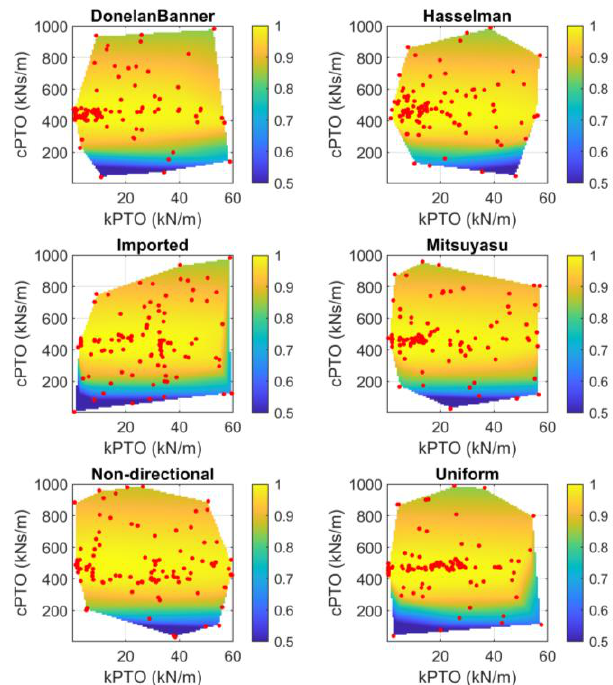
Fig. 6: Visualisation of the optimisation search space, with the colour bar showing the power produced, normalized to the maximum power produced in the non-directional case. Red dots represent the simulation results. Each panel shows a different distribution. Table 4: The first 2 columns show the optimal PTO stiffness and damping for the different optimisation cases.